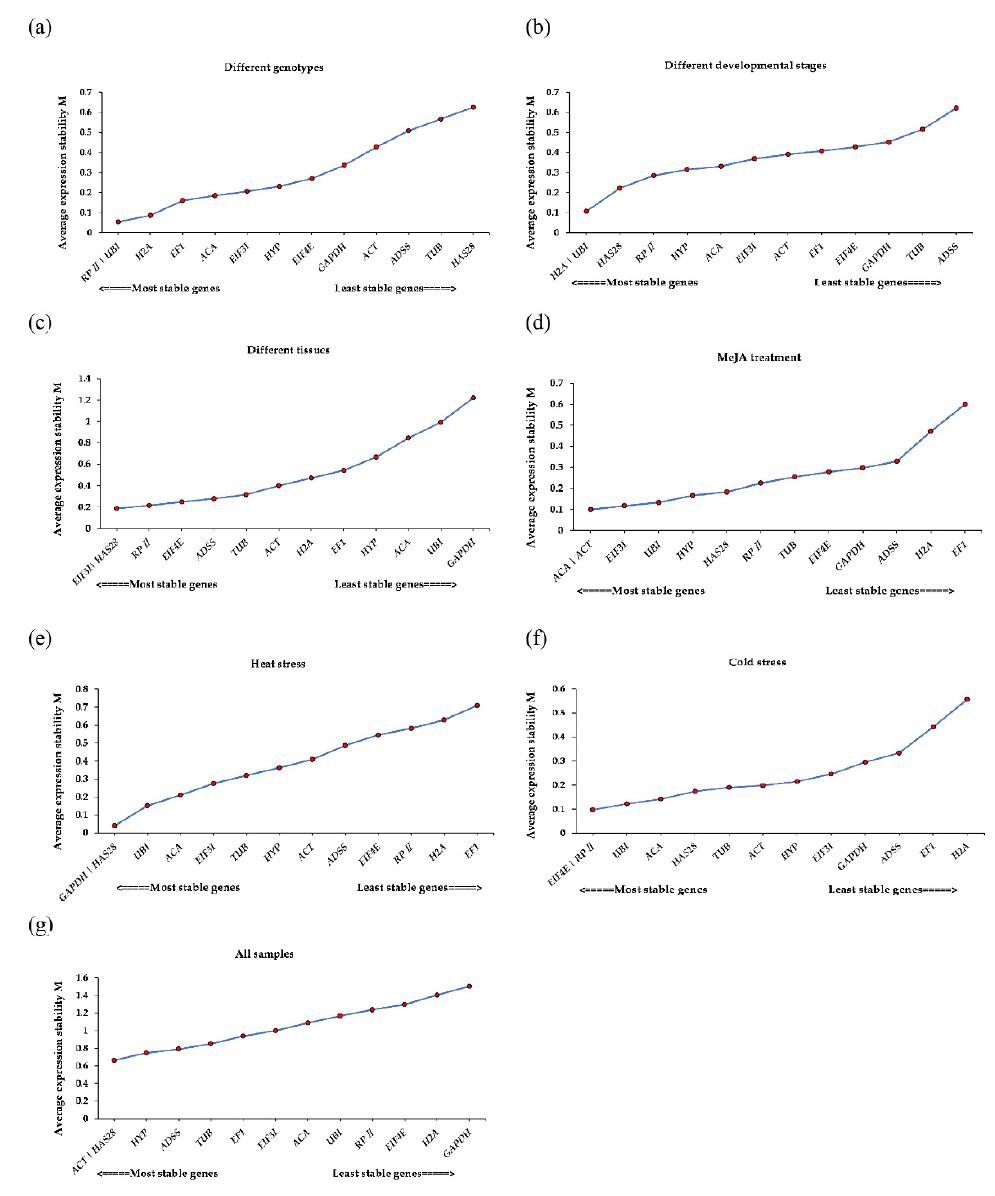
Figure 2. The stability values (Ms) of thirteen reference genes under different experimental conditions according to geNorm. ( a ) Different genotypes, ( b ) different developmental stages, ( c ) different tissues, ( d ) Methyl Jasmonate (MeJA) treatment, ( e ) heat stress, ( f ) cold stress, and ( g ) all samples.